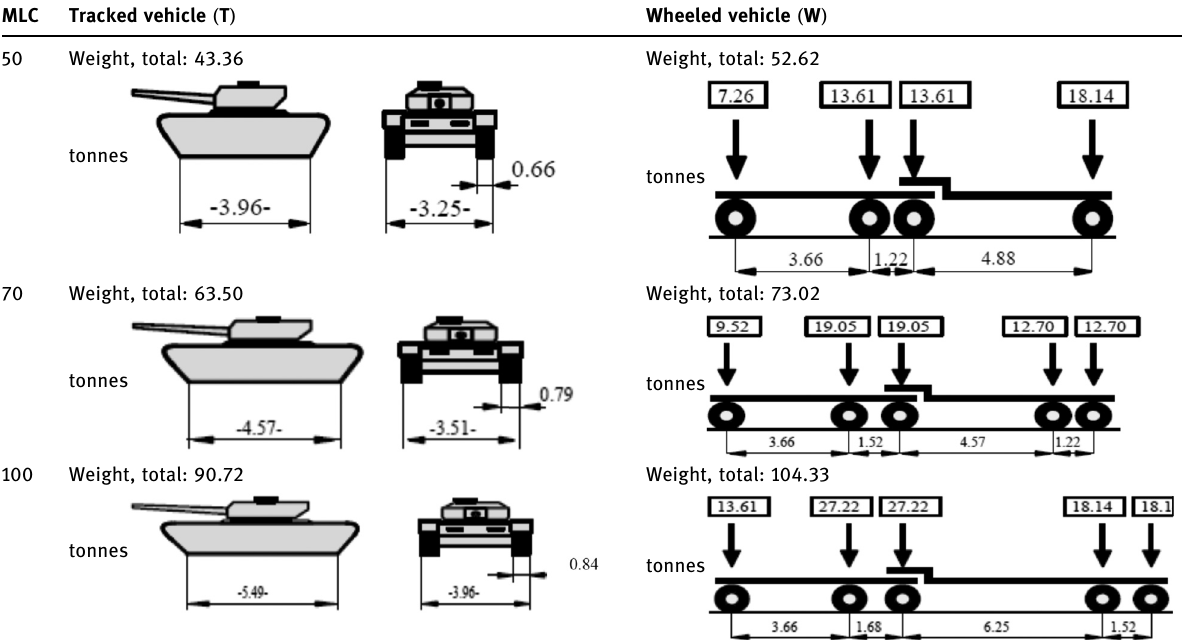
MLC Tracked vehicle ( T